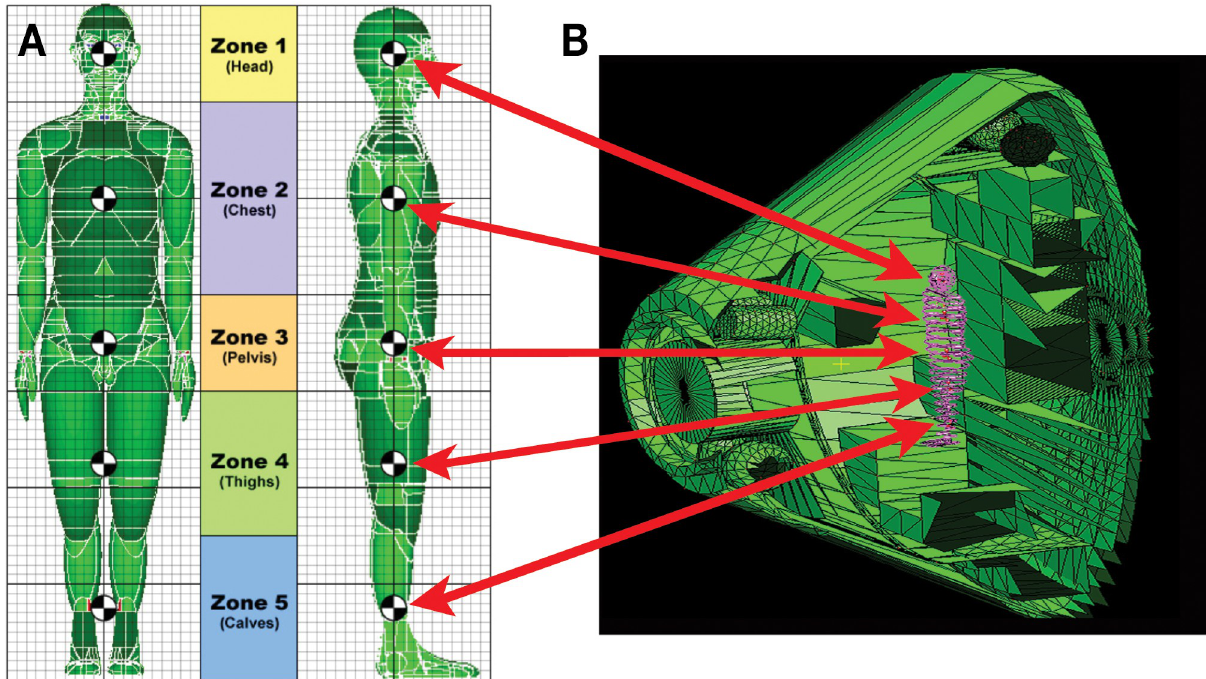
Fig 4. Vehicle shielding is combined with shielding afforded by a crew member’s body surrounding critical organs to determine the primary and secondary radiation environment at points within the crew member. (A) Human phantoms are used to calculate the body’s self-shielding of critical organs. (B) Shield thickness provided by the vehicle are depicted as green intersecting rays in a crew exploration vehicle (similar to Orion).